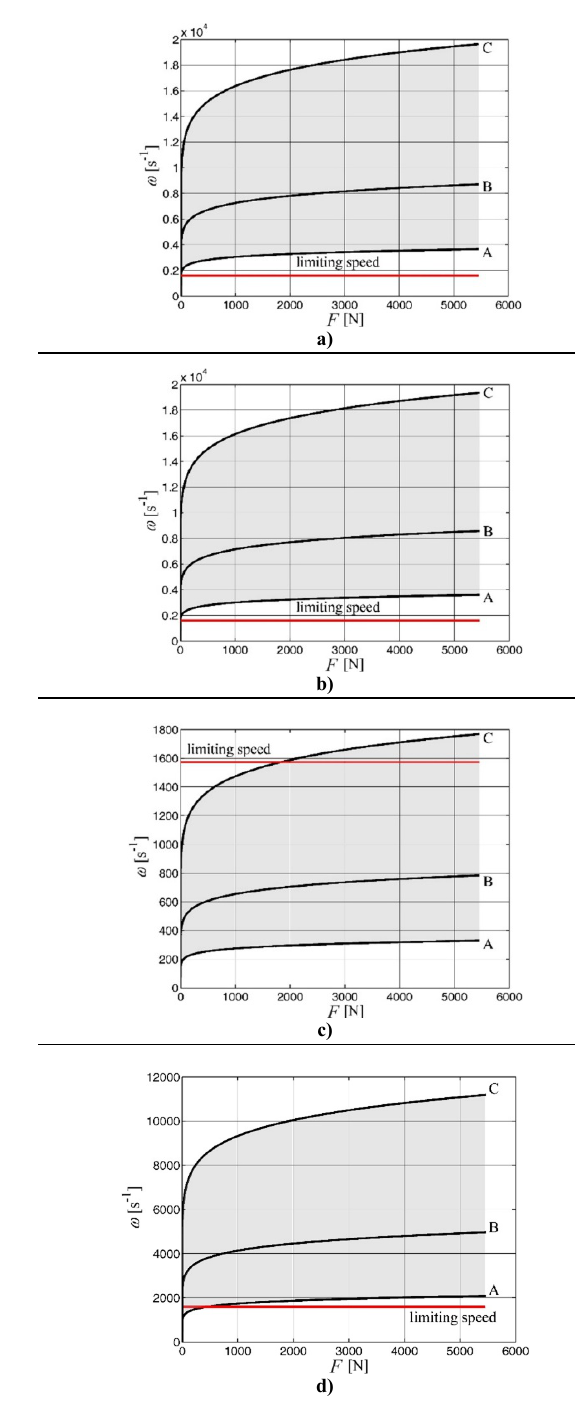
Figure 9. A plot that shows a lubrication regime dependence of angular speed ω and contact load F for rolling bearing 6206 and balls-inner raceway contact, with an operating temperature of 99°C and oil lubricant: a) Advanced Ester, b) Polyalkyl Aromatic, c) Synthetic Paraffinic Oil, d) Super-Refined Naphthenic Mineral